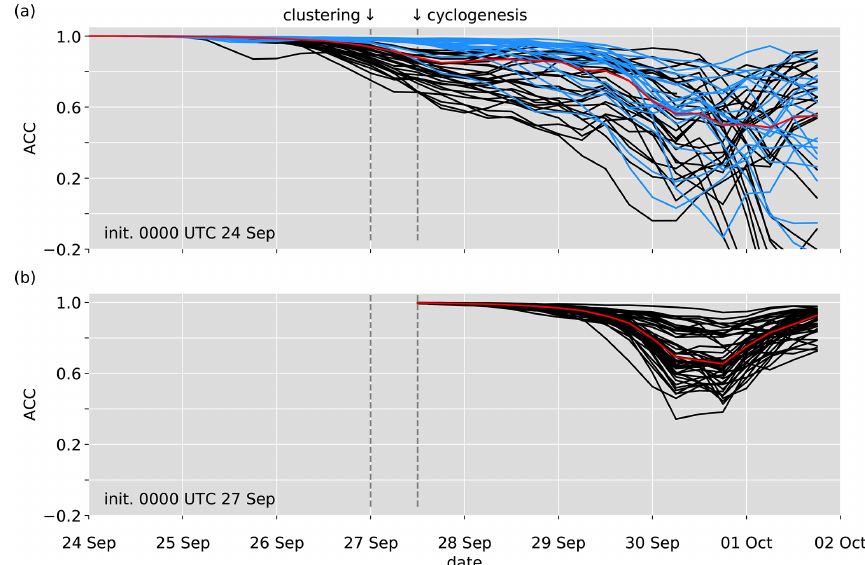
Figure 8. Temporal evolution of the anomaly correlation coefficient of geopotential height at 500hPa in the Mediterranean box (see Fig. 7) for each ensemble member (black lines) and the median (red line) of the ensemble forecasts initialized at (a) 00:00UTC 24 September 2018 (blue lines show members of cluster C) and (b) 00:00UTC 27 September 2018.